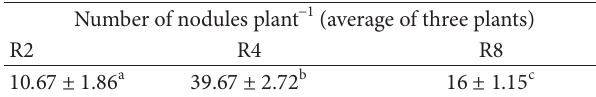
Table 1: Number of nodules at different plant growth stages. Number of nodules plant − 1 (average of three plants) R2 R4